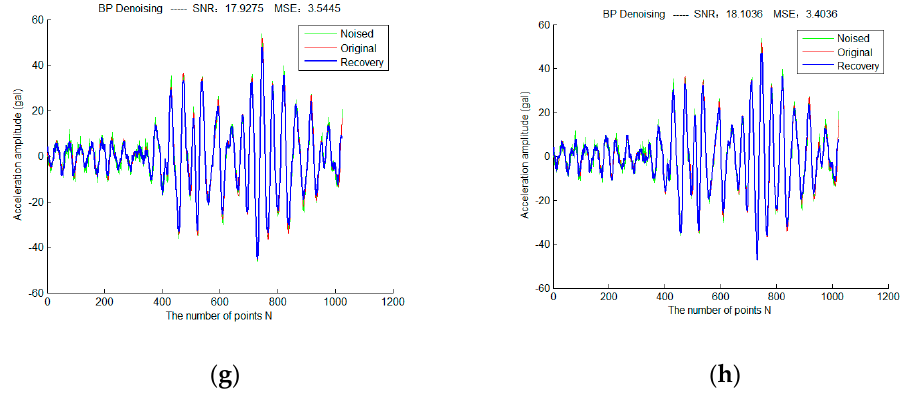
Figure 8. The Compressive Sensing Denoising Experiment of a Frame of Strong Earthquake Signals Based on Different Sampling Matrices ( a ) is the original and noise-adding waveforms of the frame signal in the time and frequency domain(sigma = 2); ( b ) is the result based on FIR filtering; ( c ) is the result based on Butterworth filtering; ( d ) is the result based on Chebyshev filtering;( e ) is the BPDN compressive sensing denoising result based on the Gauss sampling matrix; ( f ) is the BPDN compressive sensing denoising result based on the Bernoulli sampling matrix; ( g ) is the BPDN compressive sensing denoising result based on the PartHadamard sampling matrix; ( h ) is the BPDN compressive sensing denoising result based on the SparseRandom sampling matrix.